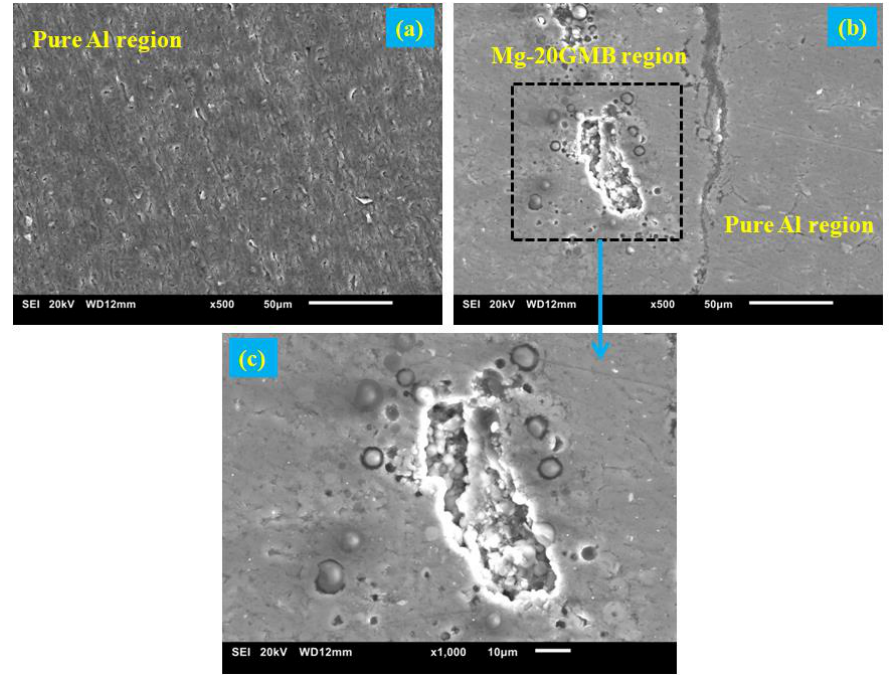
Figure 3. XRD patterns of the as-cast ( a ) pure Al (shell) and ( b ) Mg-20GMB material (core).